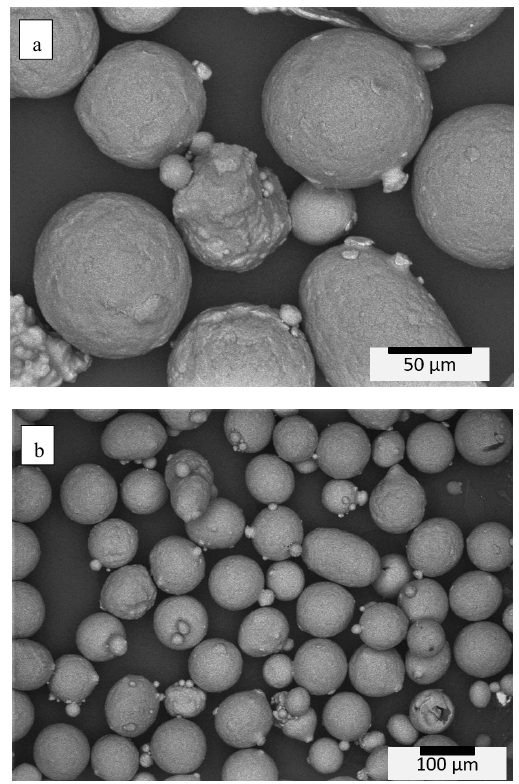
Figure 1. Ti6242 pre-alloyed powder images at high magnification ( a ) and low magnification ( b ).